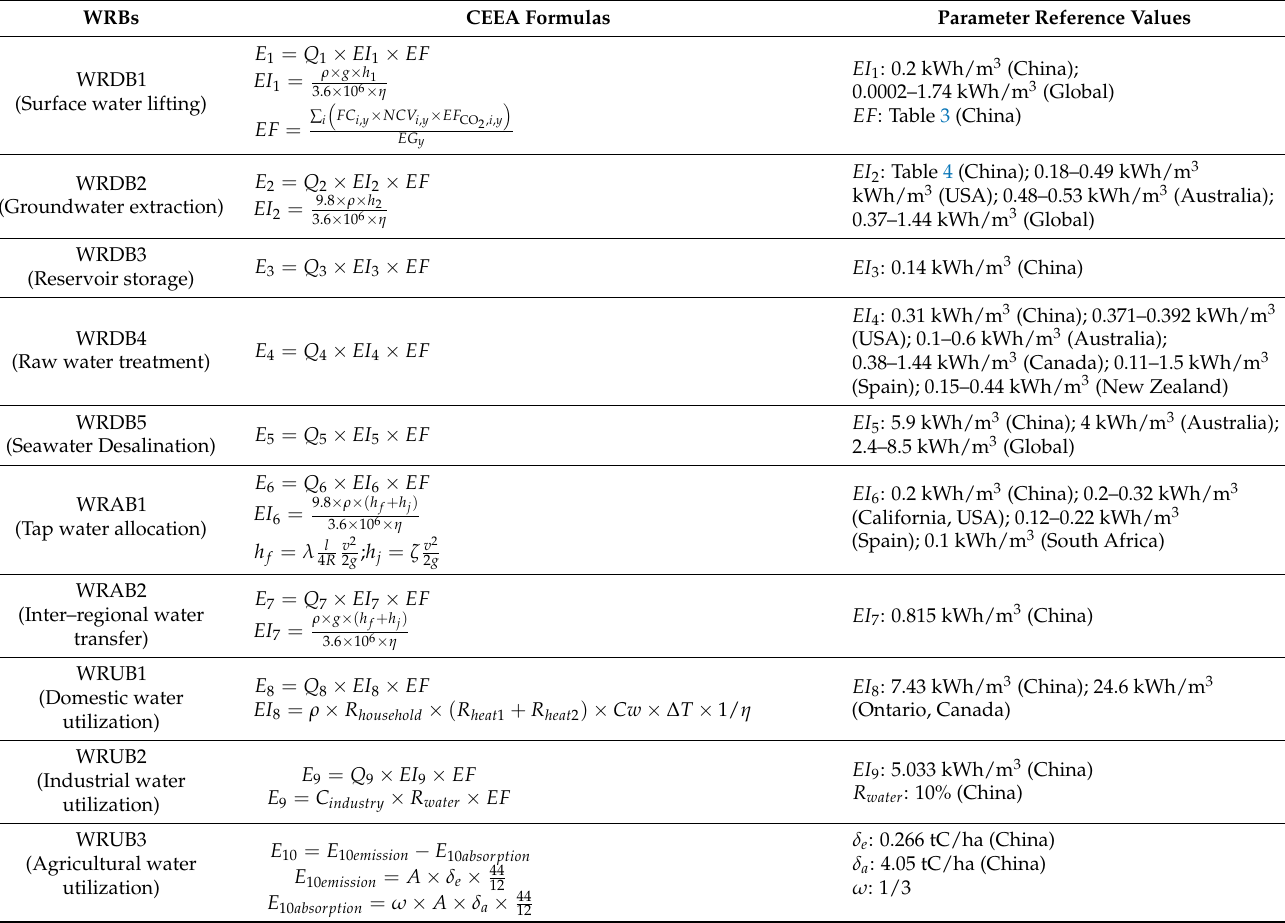
Table 2. FT-CEEA for water resource behaviors.